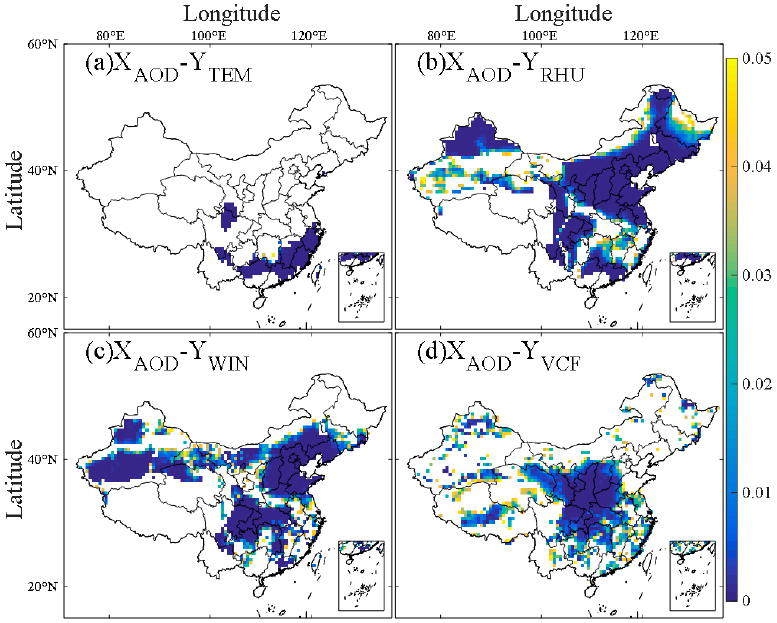
Figure 13. Granger effect of AOD on meteorological and vegetation